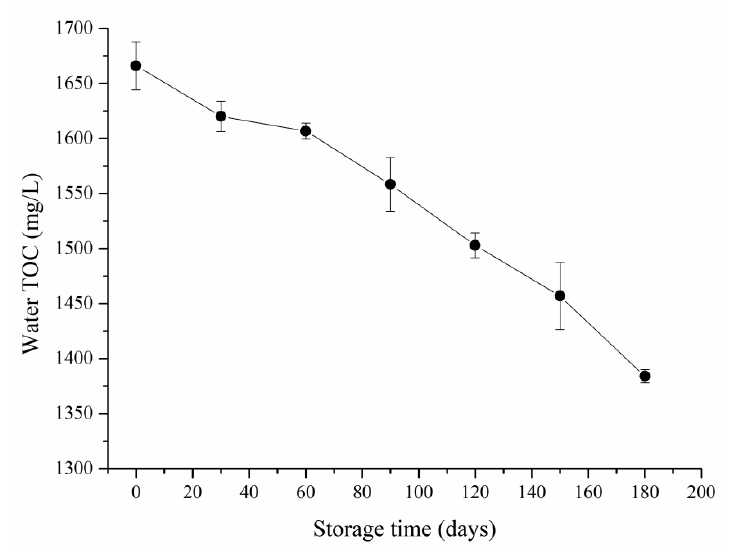
Figure 1. The swine wastewater total organic carbon (TOC) content at different storage times. Data are the means of three replications, and bars indicate standard error.